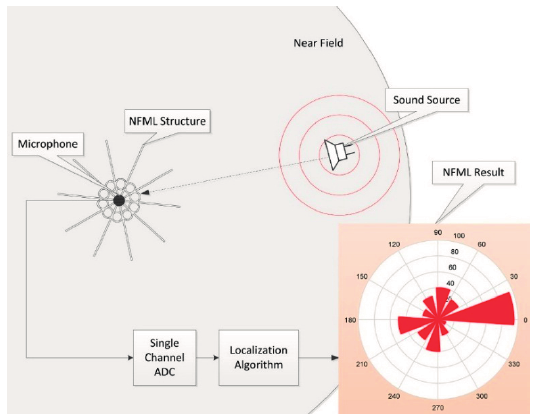
Figure 1. Functional diagram of NFML